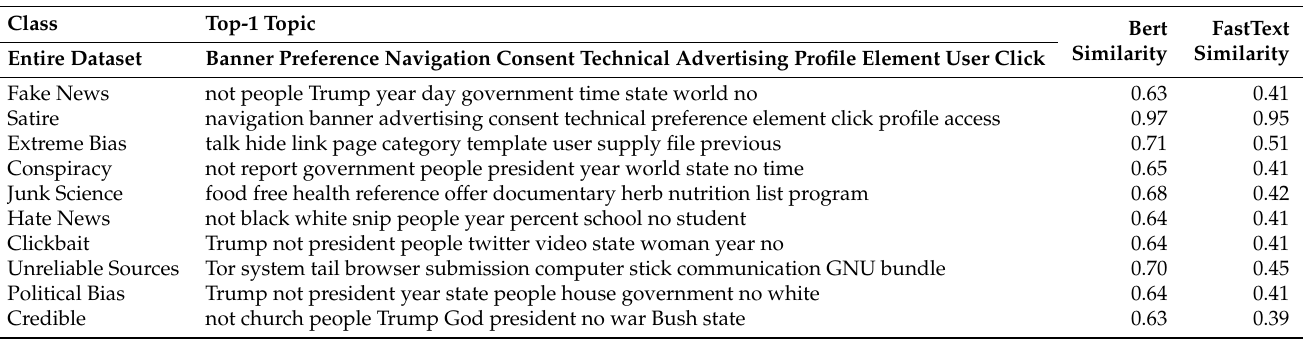
Table 4. Top-1 Topic similarity between the entire dataset and each